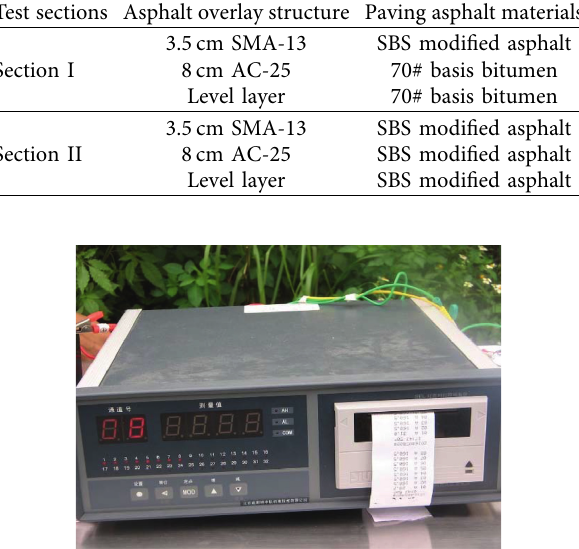
Figure 2: The instrument for recording and printing temperature